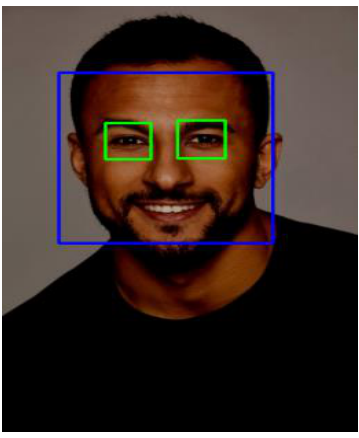
Figure 21. Slightly reduce the brightness in Figure 10.